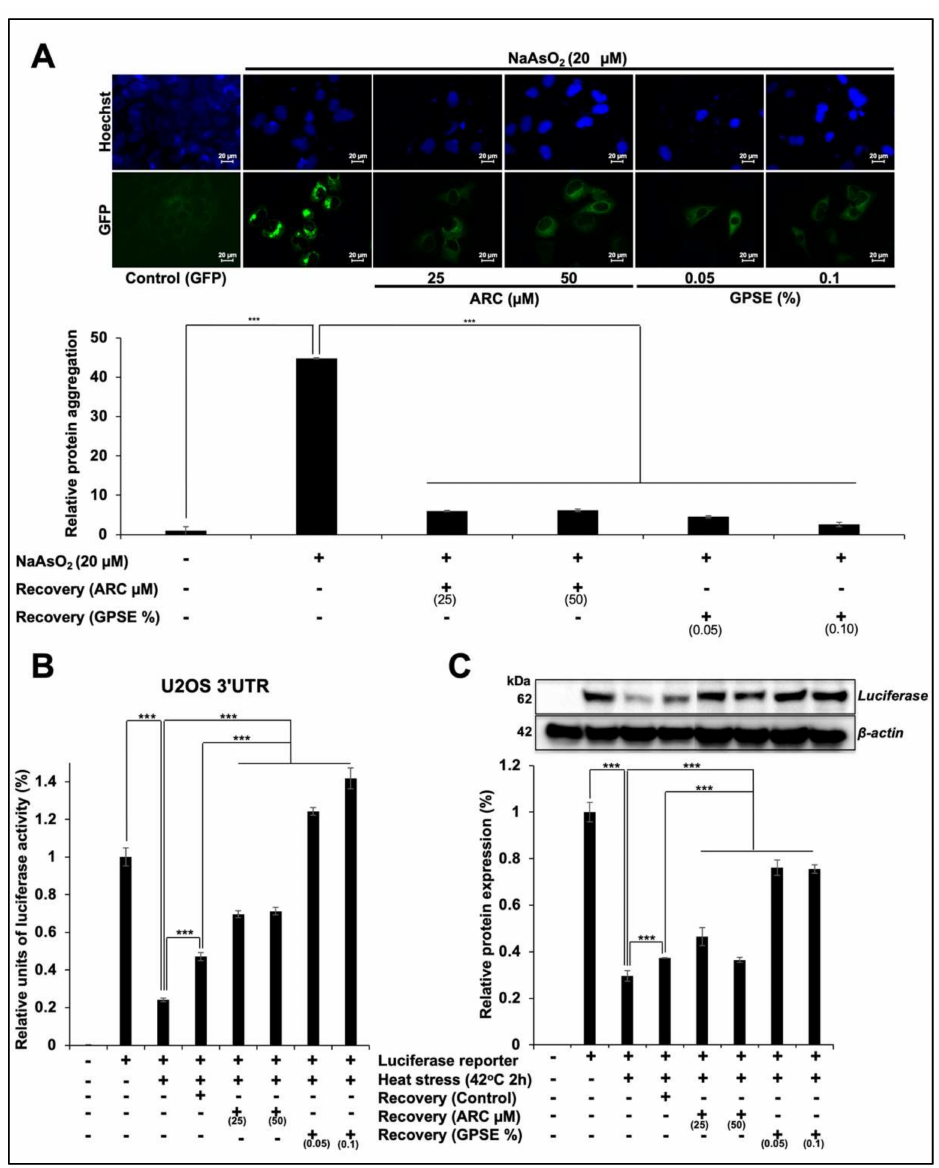
Figure 3. Low dose of GPSE protected human cells against metal stress. Cells stably transfected with GFP plasmids showed diffuse green fluorescence in the cytoplasm. Cells subjected to metal stress showed aggregation of GFP fluorescence, while the ones recovered in either GPSE- or ARC- supple- mented medium showed recovery from aggregation ( A ). Heat-stressed cells showed 80% reduction